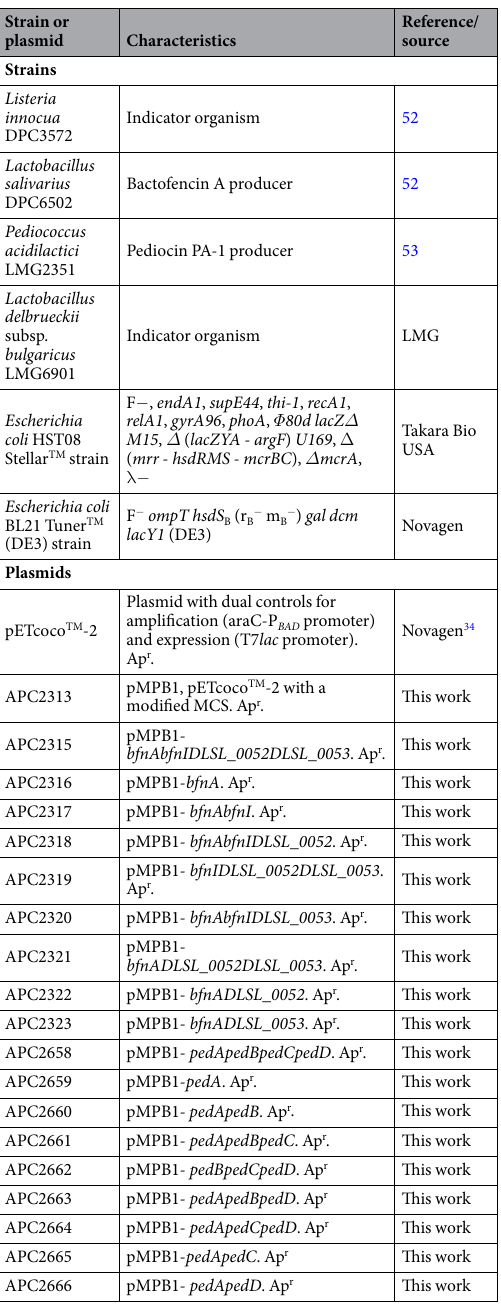
Table 1. Bacterial strains and plasmids used in this work. * MCS, Multiple Cloning site. Ap r , ampicillin